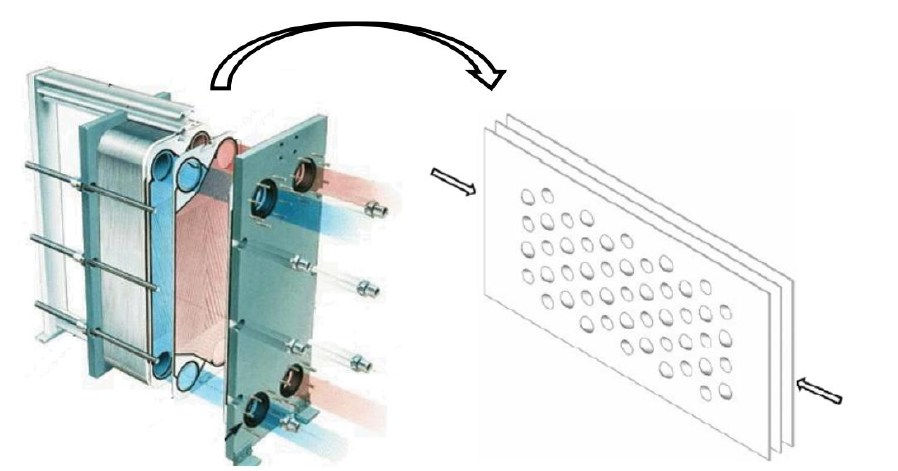
Figure 1. Structural diagram of a concave-convex plate heat